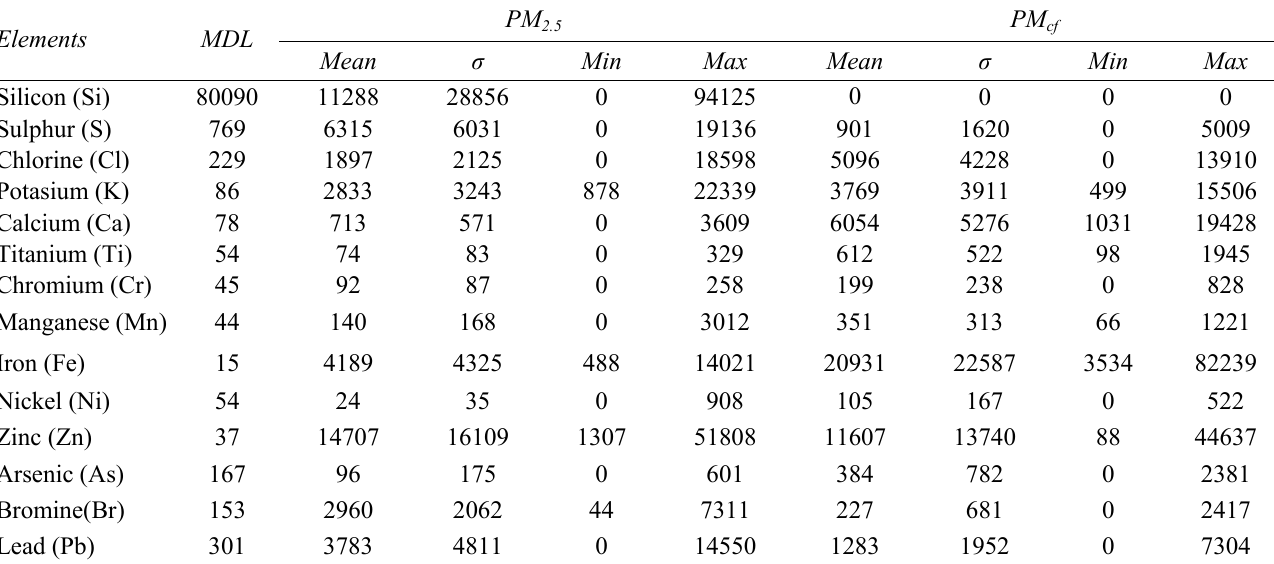
Table 3a : Arithmetic mean concentrations (ng/m 3 ) and standard deviation ( σ ) of various elements detected in aerosol samples from Mandi-Gobindgarh. MDL stands for minimum detection limit of the PIXE set up at Bhubaneshwar for the aerosol samples in (ng/m 3 ). To calculate the arithmetic mean the concentrations of the elements in the samples where these were below detection limits were taken to be zero.